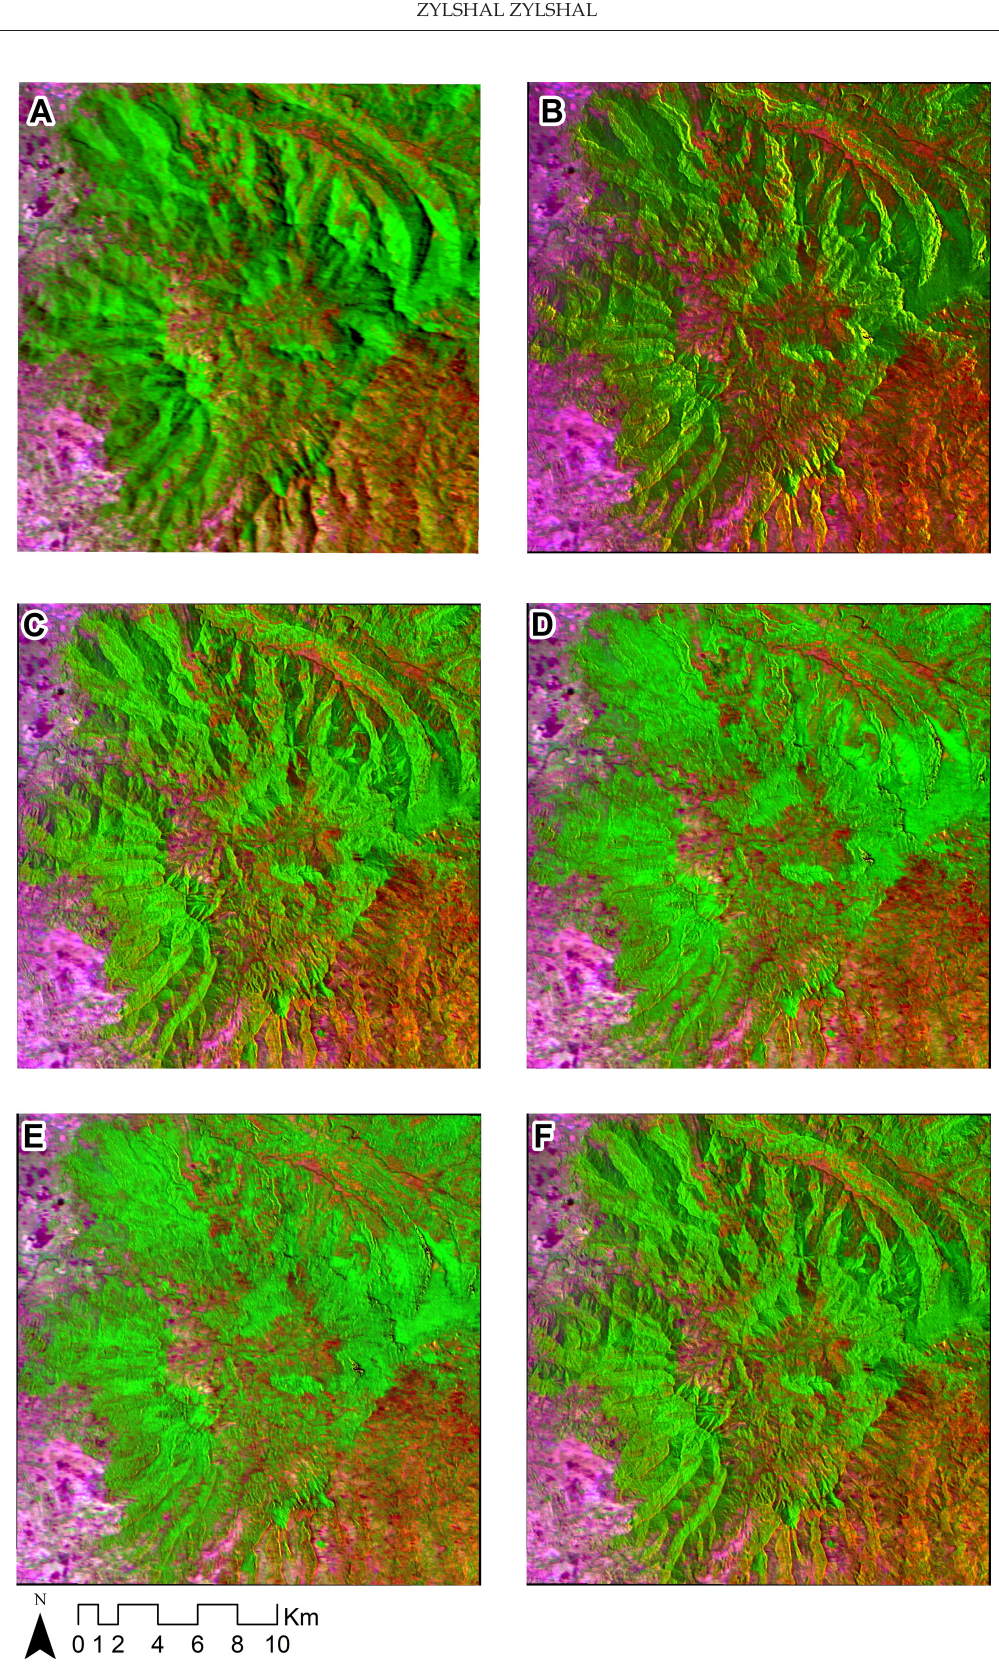
Fig. 4. A – NIR-R-B False color composite of LAPAN-A3 and after applying topographic correction algorithms: B – cosine correction, C –improved cosine correction, D – Minnaert correction, E – modifed Minnaert correction, and F – two-stage